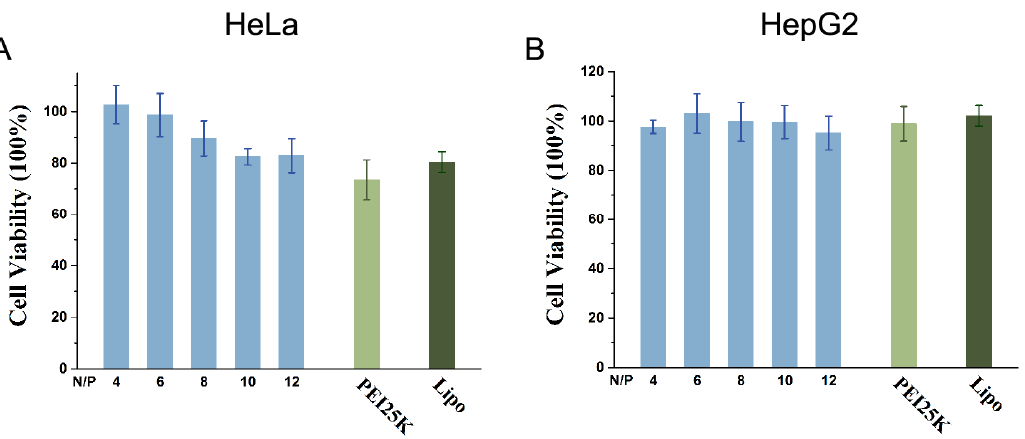
Figure 5. Cytotoxicity of the QM-SS-KK/DOPE/pDNA complexes prepared at various N/P ratios in a serum-free medium of HeLa cells ( A ) and HepG2 cells ( B ). PEI25K and lipofectamine 2000 were used as controls. Data represent mean ± SD ( n = 3).